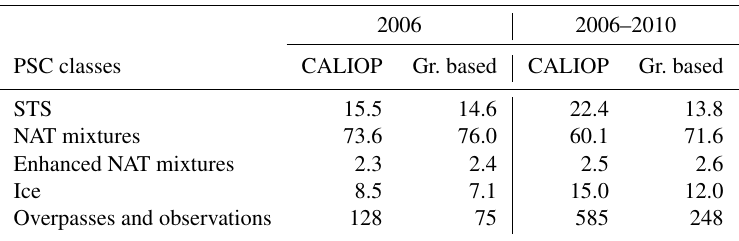
Table 1. Frequency of occurrence (in %) of PSC classes for 2006 and for 2006–2010. The last line represents the number of overpasses in the McMurdo box for CALIOP and the number of ground-based observations. Observations in the 12–30km interval have been considered. The ice-class for CALIOP also includes mountain wave ice.